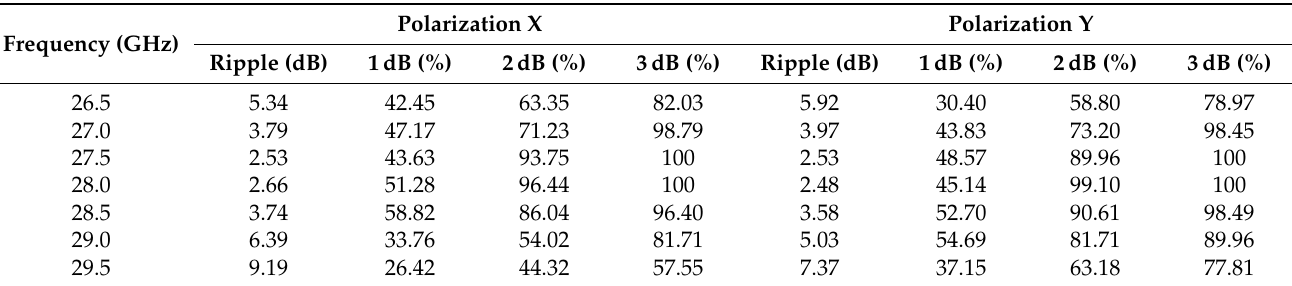
Table 3. Performance of the layout obtained after a POS at 28GHz in the whole 5G NR n257 band. XdB (%) indicates what percentage of the coverage area complies with a ripple of